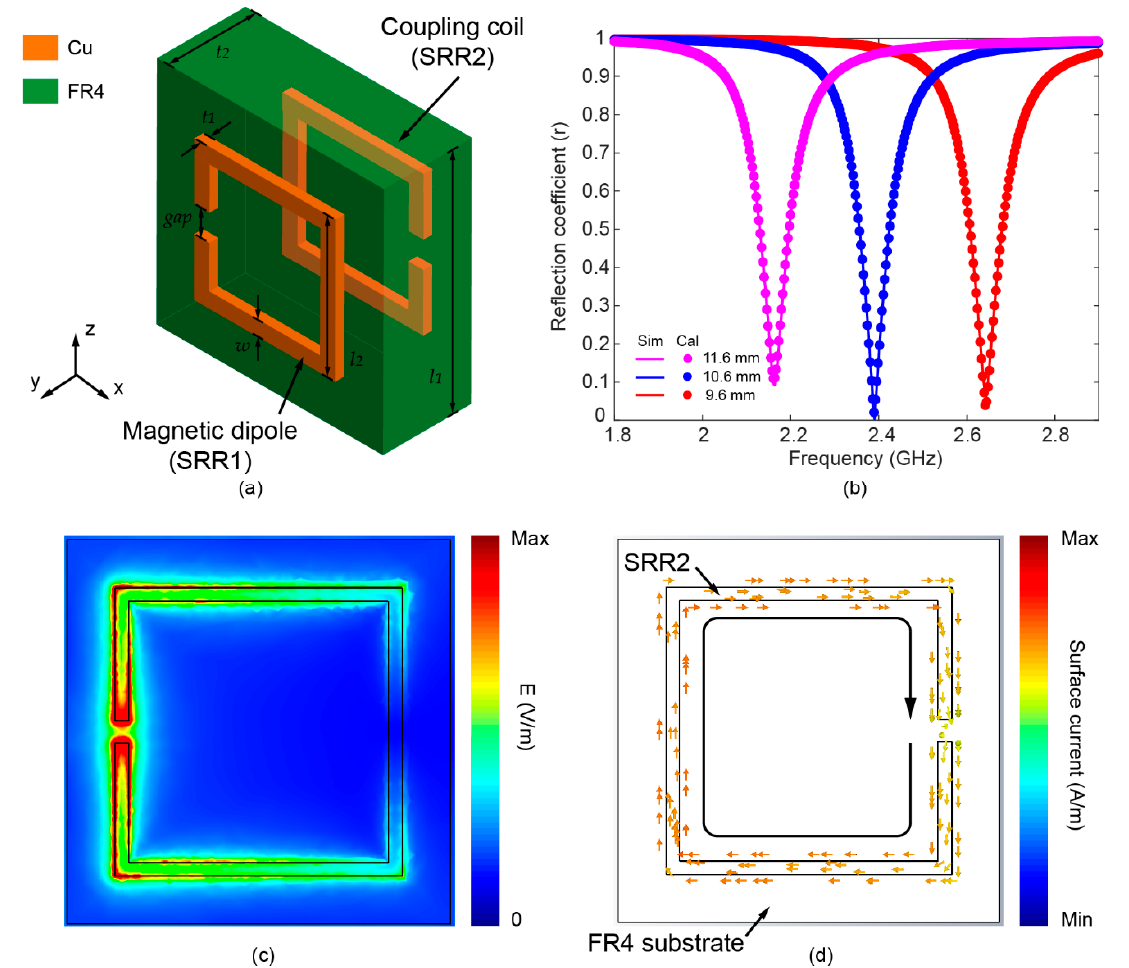
Figure 1. ( a ) The illustration of the presented metamaterial-inspired antenna (MIA). ( b ) Simulated and calculated reflection coefficients of the MIA with various lengths of SRRs ( l 2 ). ( c ) The simulated electric field distribution in the plane of resonant magnetic dipole (SRR1). ( d ) The simulated surface current in the plane of coupling coil (SRR2).